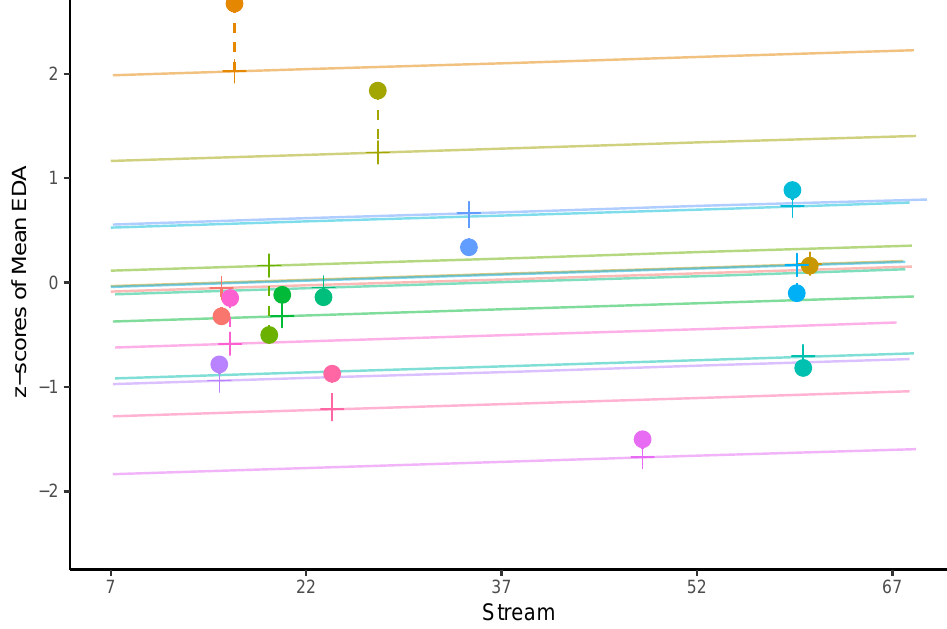
Figure 2. Individual predicted standardized mean EDA from the optimal S TREAM for the non- adaptive condition (crosses) with individual regression lines, as well as the actual mean EDA (points) at local maxima of